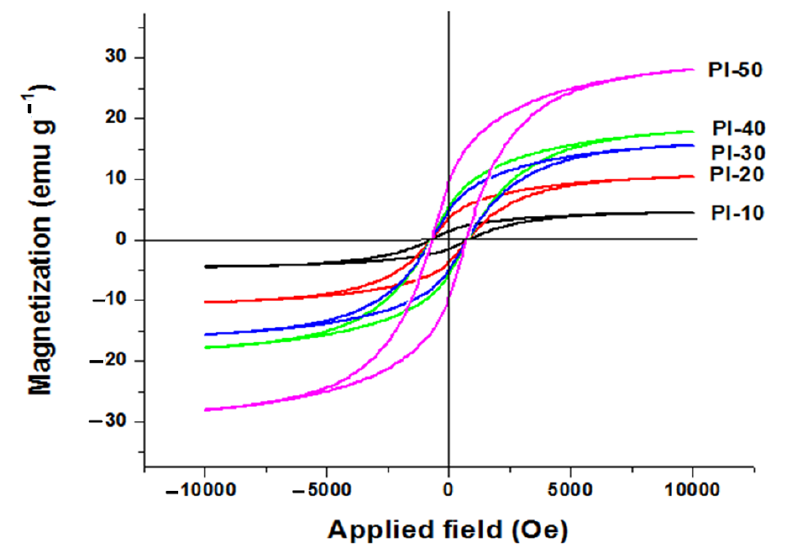
Figure 3. Hysteresis loops of the magnetic PEI/CoFe 2 O 4 films. Table 2. Magnetic parameters Ms, Mr , and Hc of the PEI//CoFe 2 O 4 films. Table 2. Magnetic parameters Ms , Mr , and Hc of the PEI//CoFe